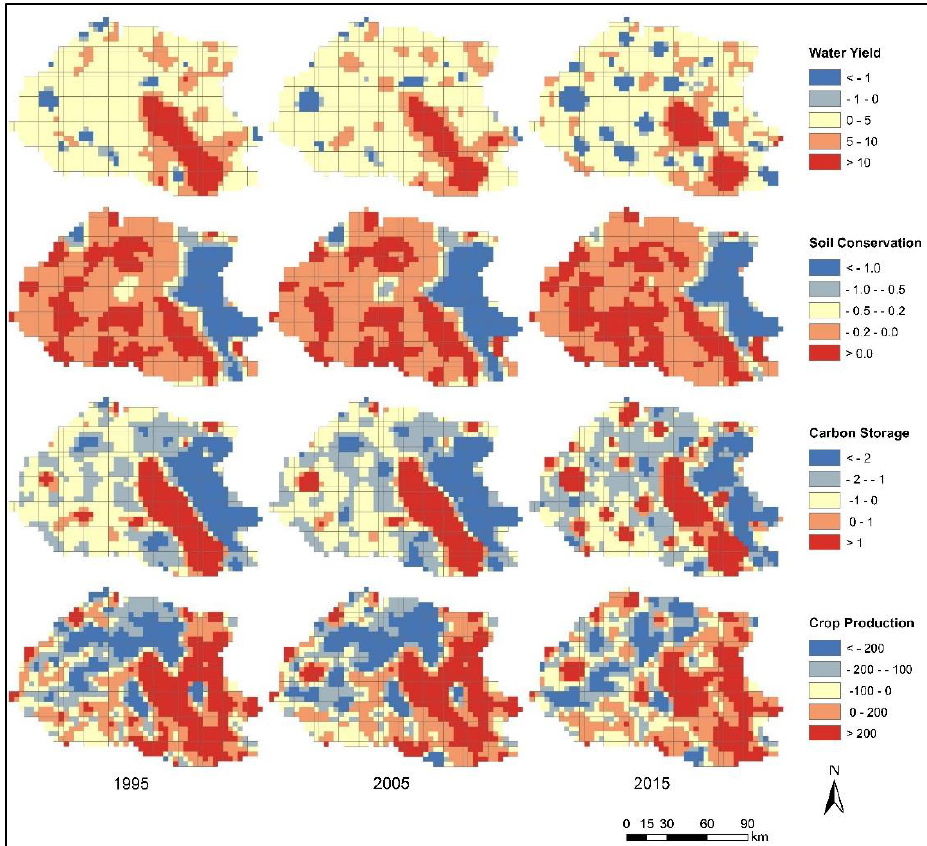
Figure 7. Spatial distributions of correlation coefficients between edge density (ED) and ecosystem services.